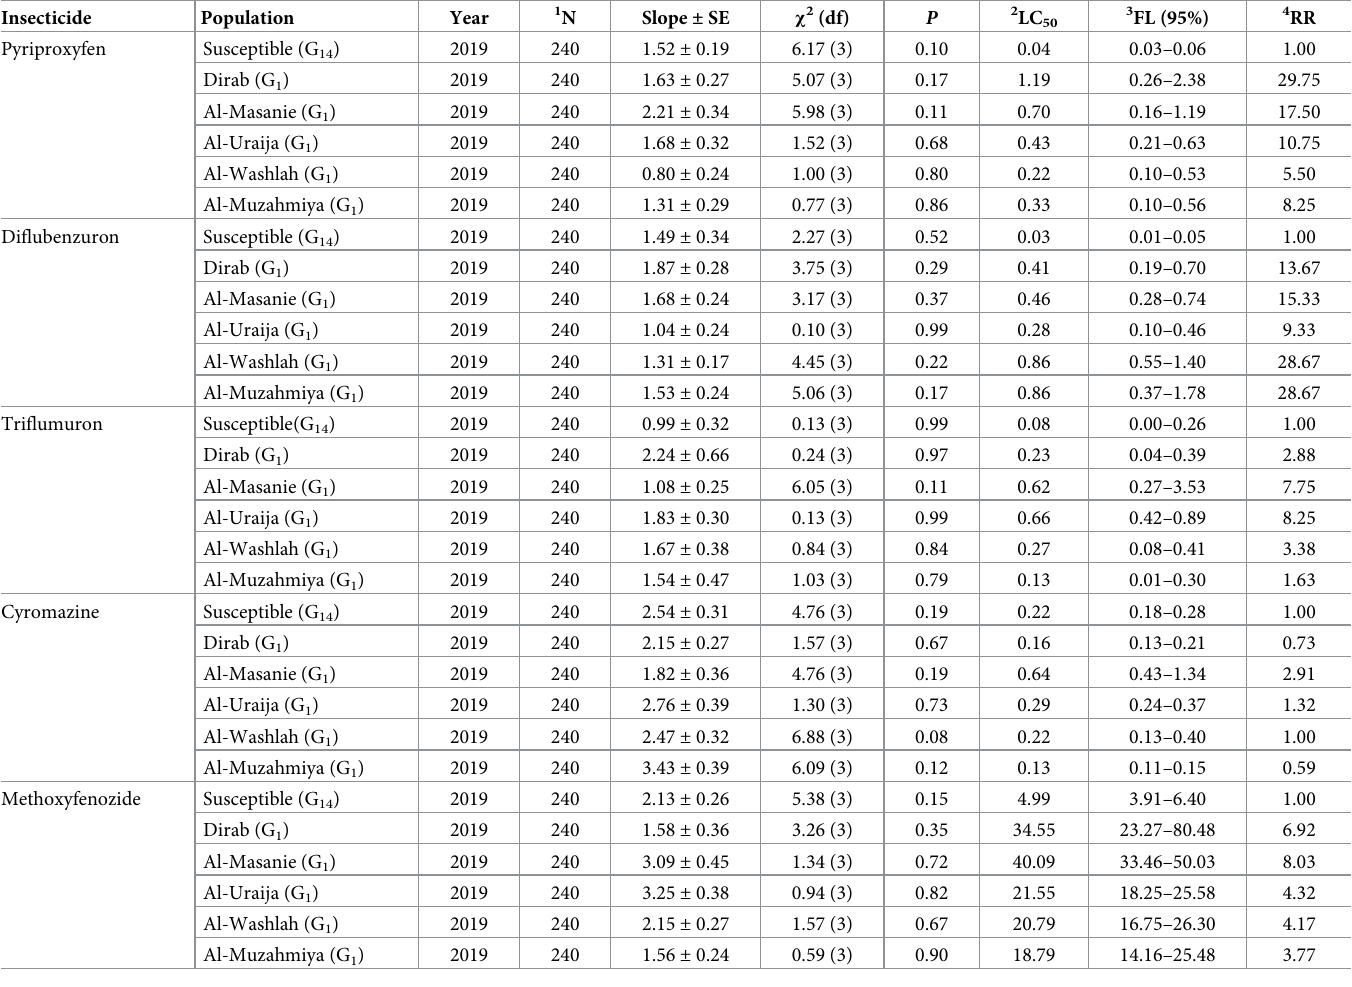
Table 1. Resistance to insect growth regulators in the larvae of different dairy farms M . domestica